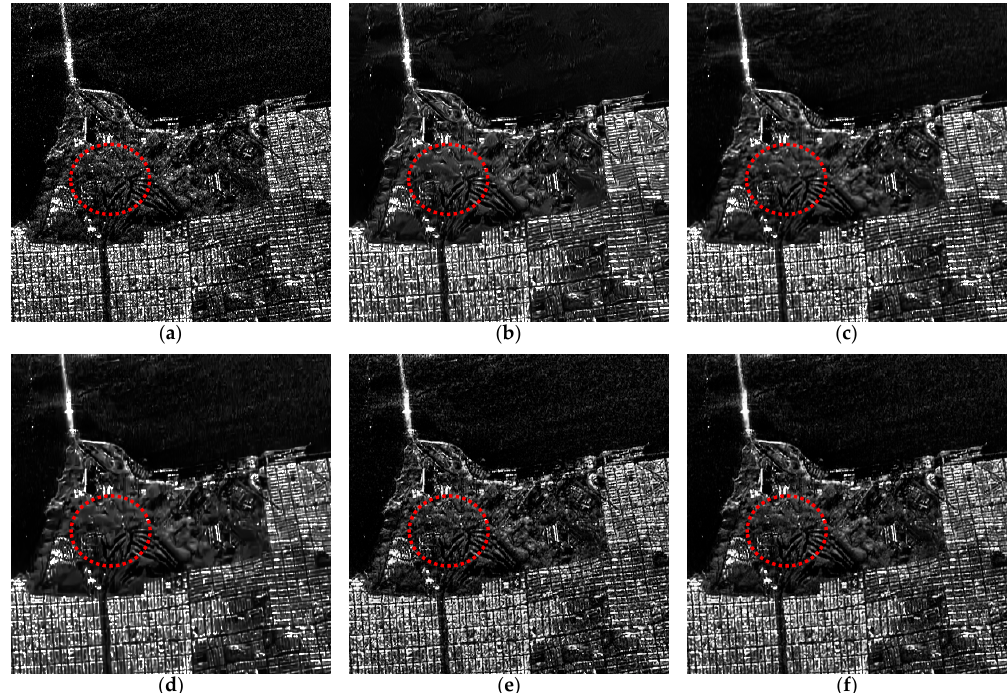
image. ( b ) PPB [13]. ( c ) SAR-BM3D [14]. ( d ) SAR-POTDF [16]. ( e ) SAR-CNN [28]. ( f ) SAR-DRN.